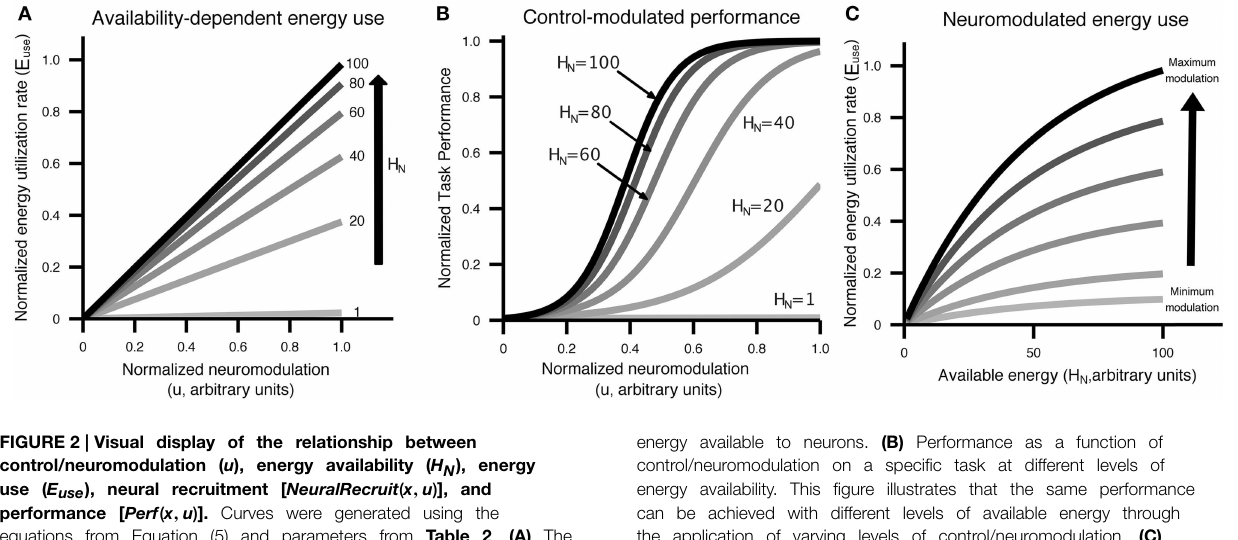
energy available to neurons. (B) Performance as a function of control/neuromodulation on a specific task at different levels of energy availability. This figure illustrates that the same performance can be achieved with different levels of available energy through the application of varying levels of control/neuromodulation. (C) Energy utilization has an upper bound and is affected by both control/neuromodulation and energy availability.